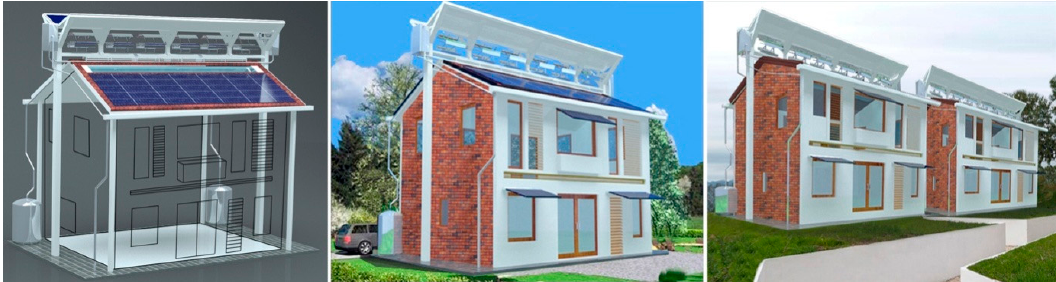
Figure 1. Artistic expression of a hybrid renewable energy harvester system for a residential building.